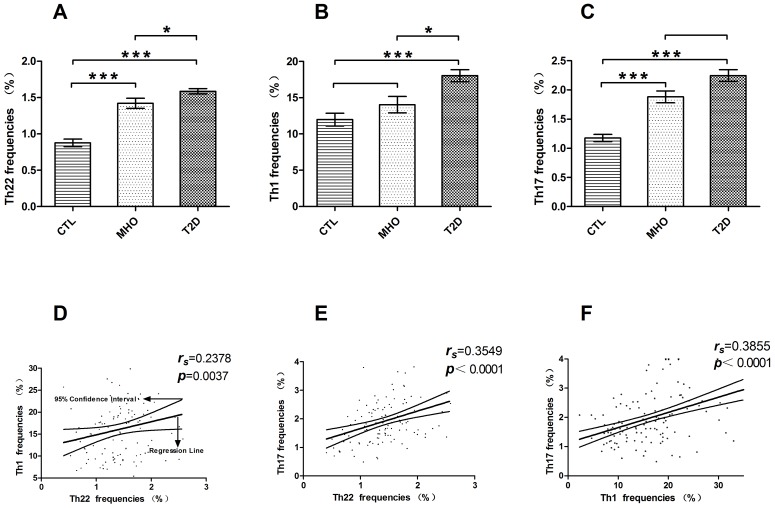
Increased percentages of Th22 cells in peripheral blood from MHO and T2D patients and their correlation with Th1/Th17 frequencies.Circulating percentages of Th22, Th1, and Th17 cells from CTLs, MHO, and T2D patients. (A) Significantly increased percentages of Th22 cells in MHO (1.88±0.10%) and T2D patients (2.247±0.10%) as compared to CTLs (1.18±0.06%) (*P<0.0001). Increased percentages of Th22 cells were also found in MHO patients as compared to T2D patients (*P<0.05). (B) Significant increases in Th1 cells were observed in T2D patients (median, 17.73%; range, 4.652%–42.52%) as compared to CTLs (median, 11.17%; range, 4.724%–25.70%; *P<0.0001) and MHO patients (median, 15.23%; range, 2.297%–27.56%; *P<0.05). There was no significant difference between MHO patients and CTLs. (C) Significantly elevated percentages of Th17 cells were found in T2D (median, 2.08%; range, 0.48%–5.25%; *P<0.0001) and MHO patients (median, 1.815%; range, 1.10%–3.21%; *P<0.0001) as compared to CTLs (median, 1.18%; range, 0.60%–1.80%). There was no significant difference between MHO and T2D patients. (D, E, F) Correlation between the percentages of Th22, Th1, and Th17 cells from all blood donors. There was a positive correlation among all three subsets of helper T cells. Bars represent SEM. Numbers in each figure denote Spearman r and P values.